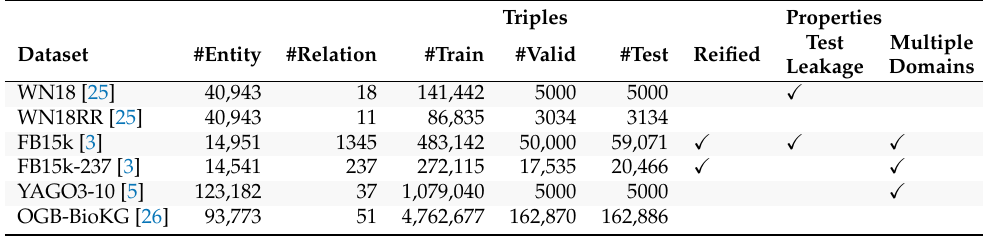
Table 3. Statistics on datasets composition.